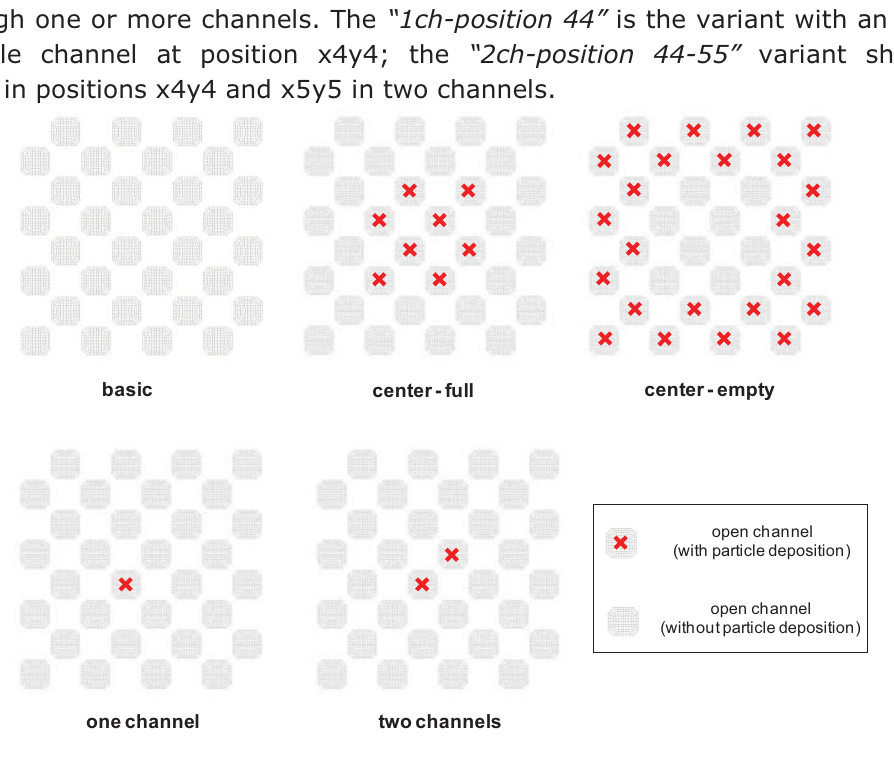
Figure 2: List of select situations in the DPF